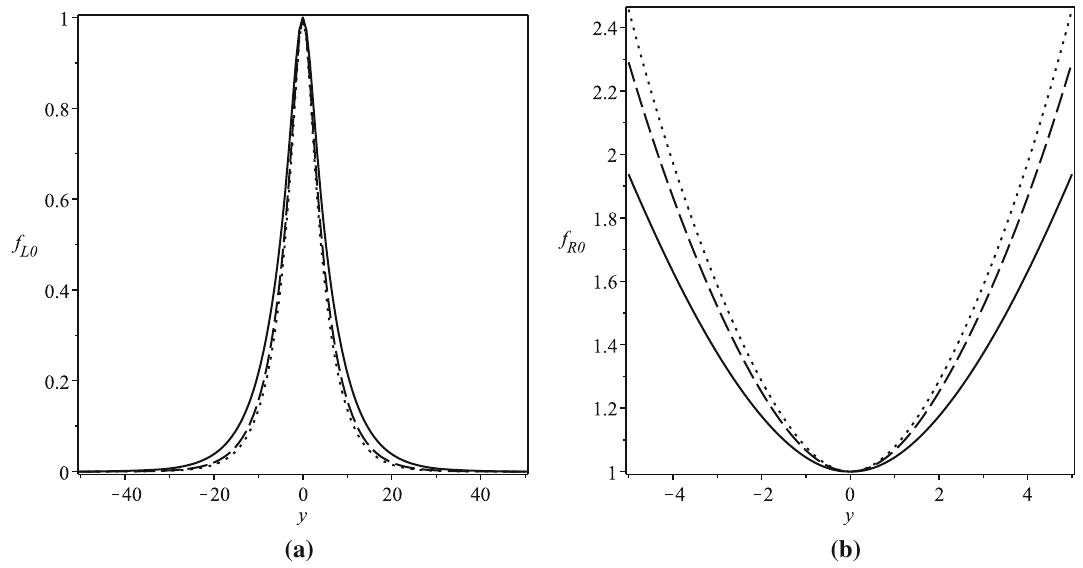
Fig. 8 The profile of a the left-handed zero mode and b the right-handed zero mode for a = 1 (solid line), a = 2 (dashed line), a = 5 (dotted line), η =